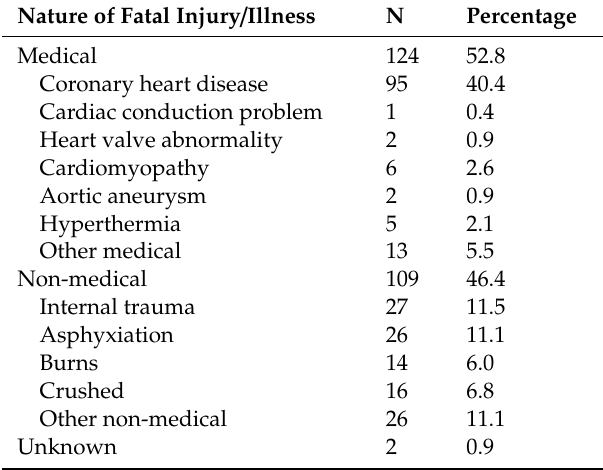
Table 2. Duty-related firefighter fatalities investigated by NIOSH by nature of fatal illness / injury for incidents that occurred 9 January 2008–10 February 2017 (N =